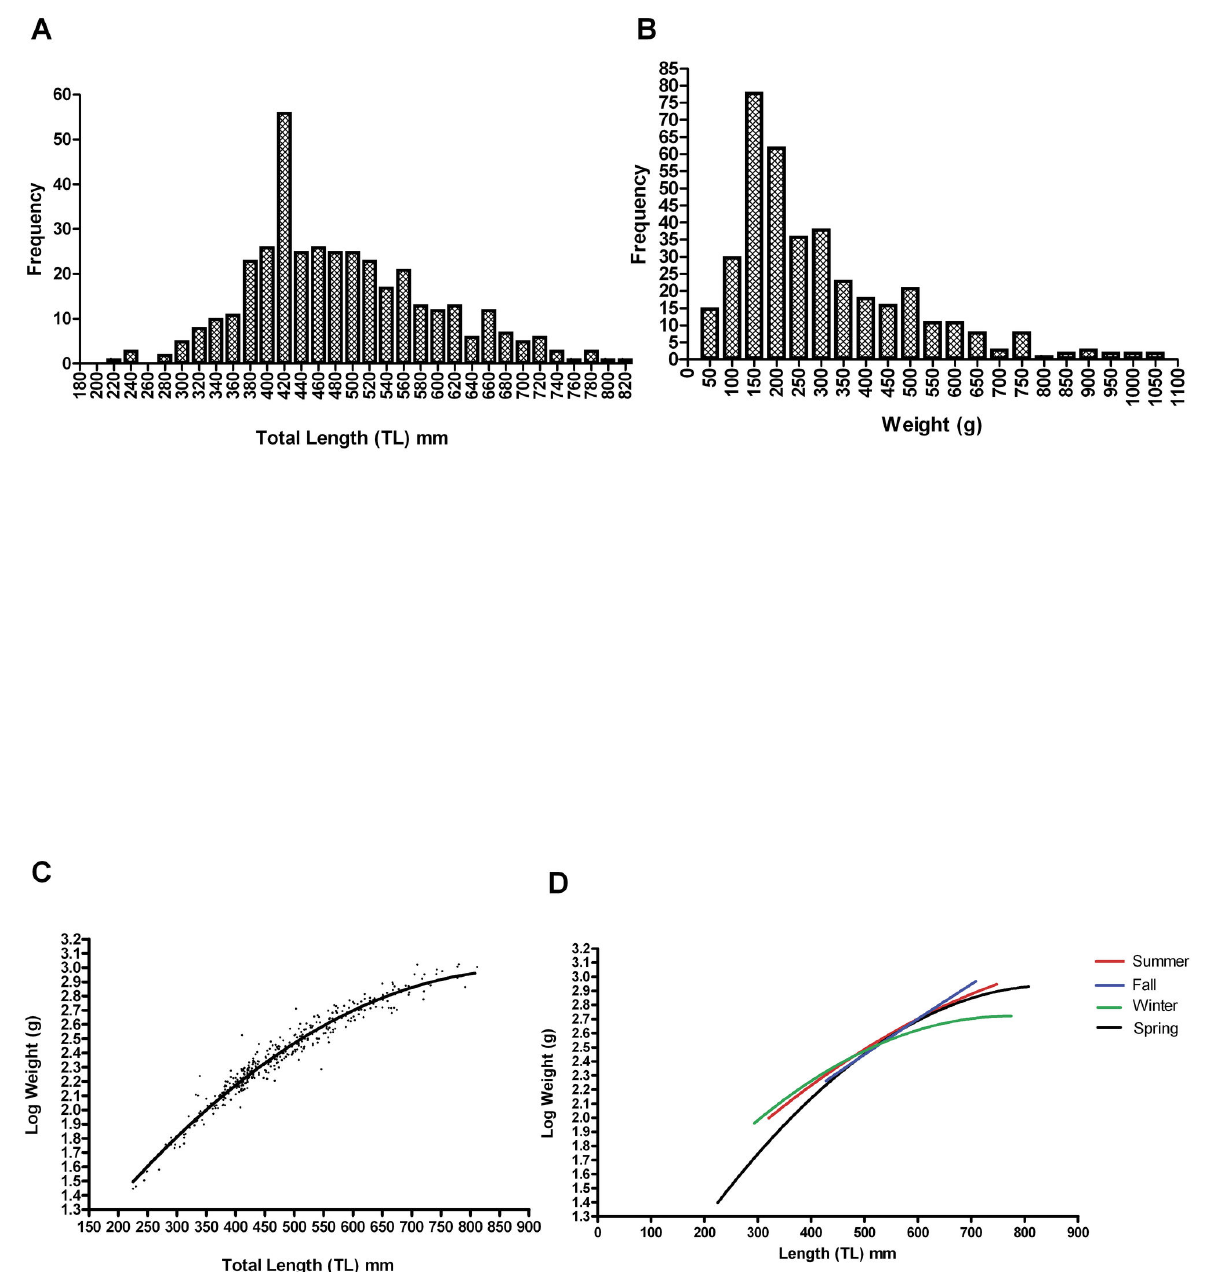
Figure 7. Length and weight data. (a) A histogram of total length (TL) data for this study (see Table 2 for related statistics). (b) A histogram of weight data for this study (see Table 2 for related statistics). (c) A non-linear regression curve of log weight on TL. [LogW=a+bL+cL 2 ; a=0.320, b=0.00022, c=-3.347e-006; R 2 =0.951; Sy.x=0.064; for other related statistics see Table 2]. (d) A seasonal comparison of L:W relationships. Large, sexually differentiated animals are heaviest in the fall and lightest in the